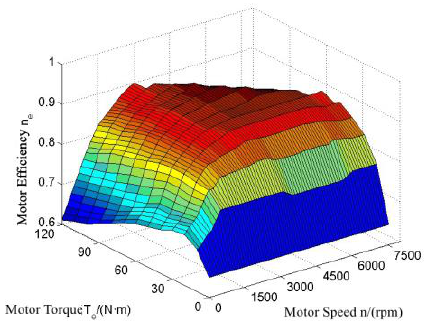
Figure 3. The motor efficiency model.